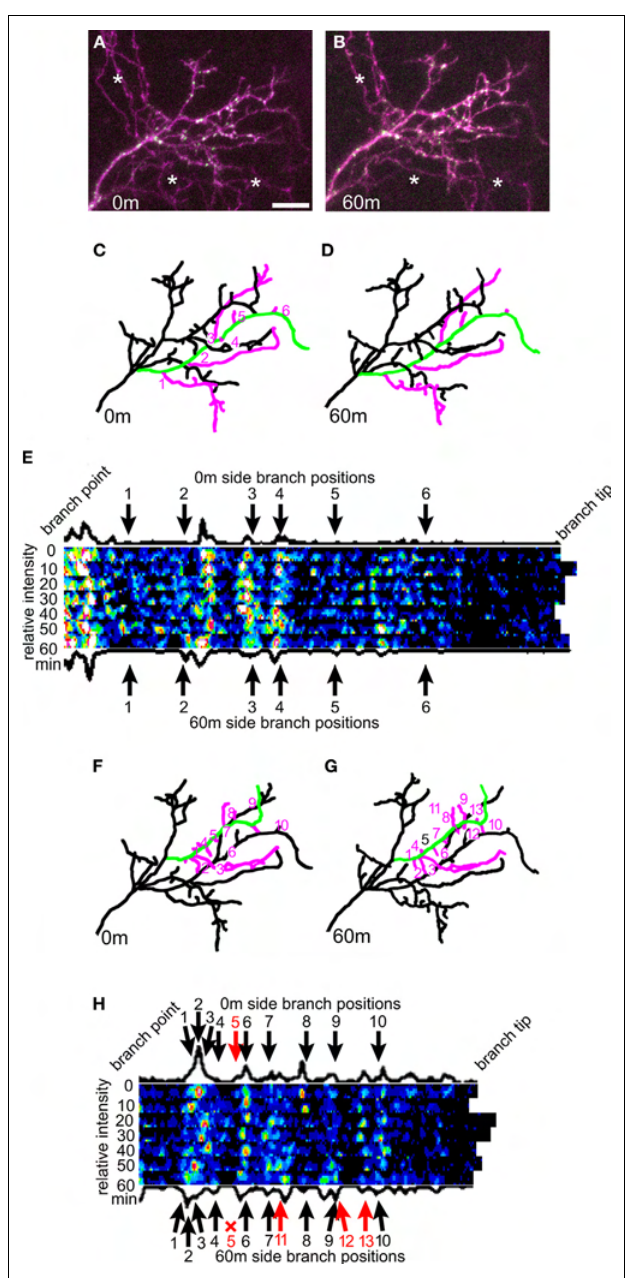
FIGURE 7 | Dendritic branching is not predicted from RNP puncta positions. (A,B) Example of a tectal neuron expressing CPEB–CFP/YFP imaged once every 10 min over 1 h at the 0-min (A) and 60-min (B) time point. (C,D) Projection of the 3D reconstruction made from the 0-min (C) and 60-min (D) time point. The six side branches (in pink) that appear on the green branch are stable for the duration of the 60-min experiment. (E) The green branch from (C) and (D) was digitally linearized for each of the seven time points, and the CFP fl uorescence along the branch is shown with the branch positioned with the branch tip to the right. The arrows indicate the branch point sites of the six side branches. (F,G) The green branch in this representation of the 0-min time point (F) and 60-min time point (G) loses its 5th side branch and gains three side branches (11, 12, and 13) over the 1 h time-lapse period. (H) The CFP content of the green branch from (F) and (G) as described in (E) . Scale bar = 10